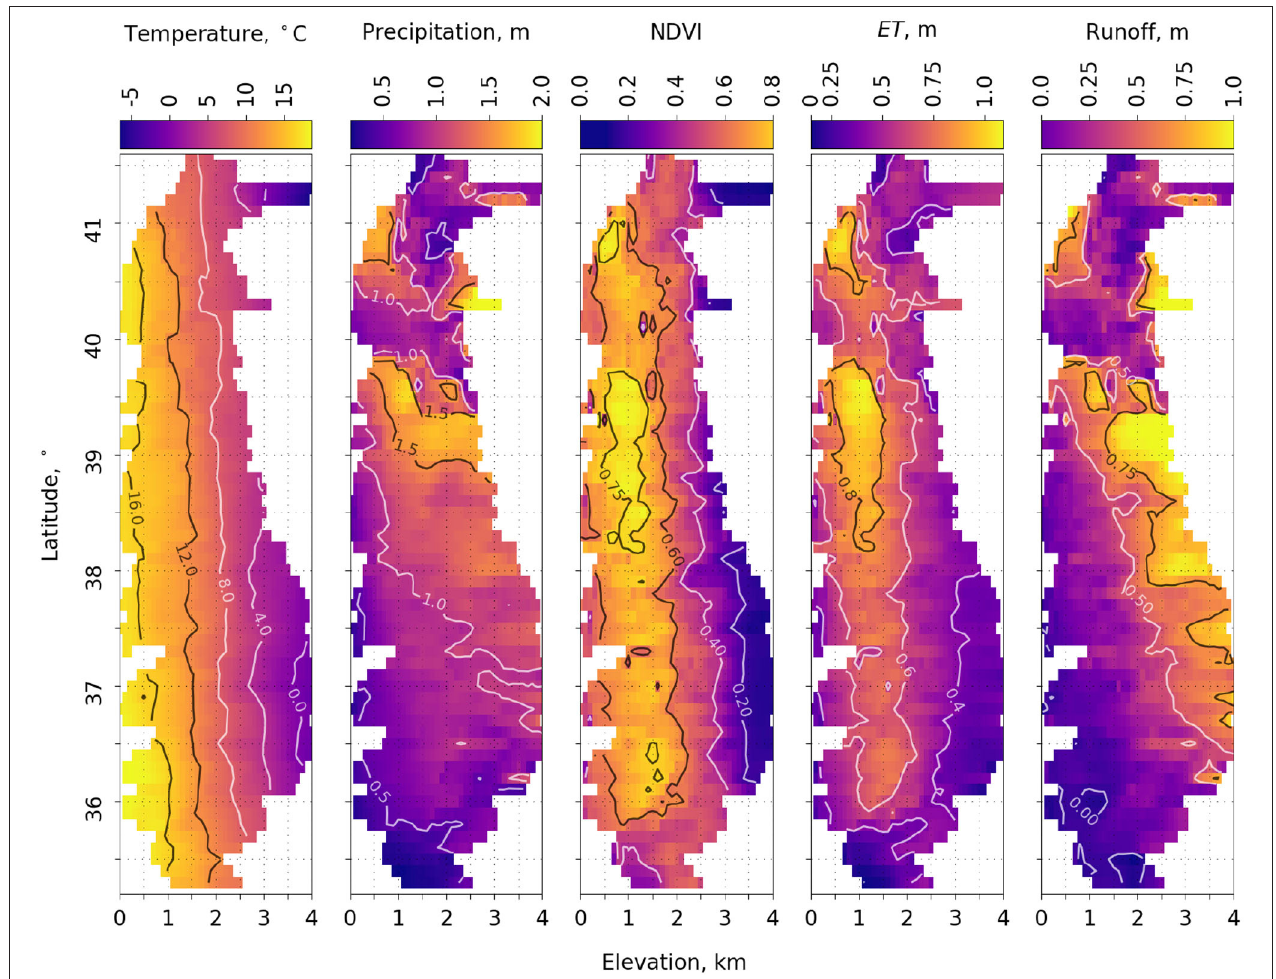
FIGURE 4 | Maps of 2001–16 average 800-m PRISM temperature and precipitation, MODIS NDVI, predicted evapotranspiration ( ET ) (Equation 1), and runoff calculated as the difference of precipitation and evapotranspiration by latitude and elevation. Different color contour lines are to improve clarity only. See Supplementary Figure 5 for patterns of P, ET , and P – ET in wet, dry and normal years.